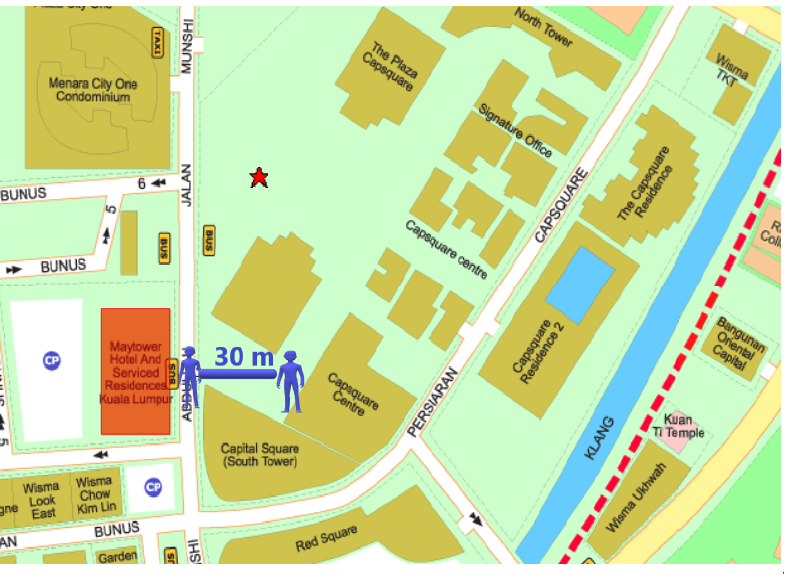
Figure 15. The itinerary followed.